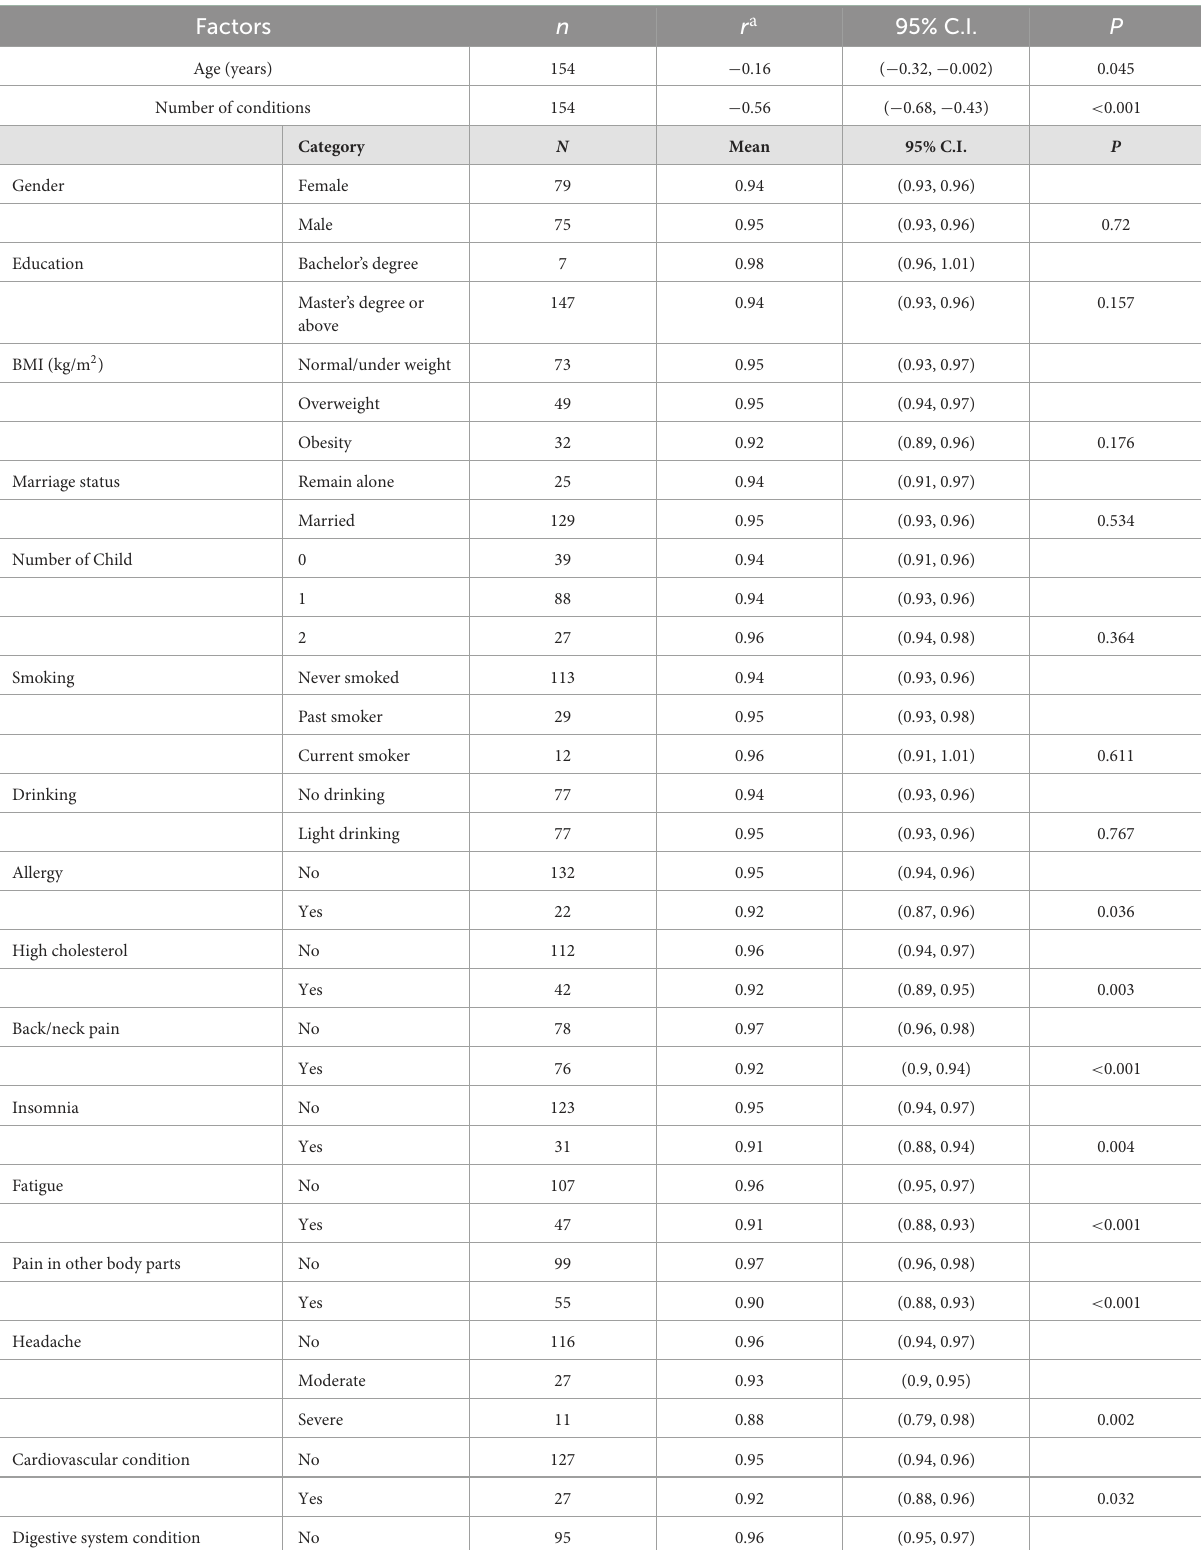
TABLE 3 Comparisons of health utility among different levels of each